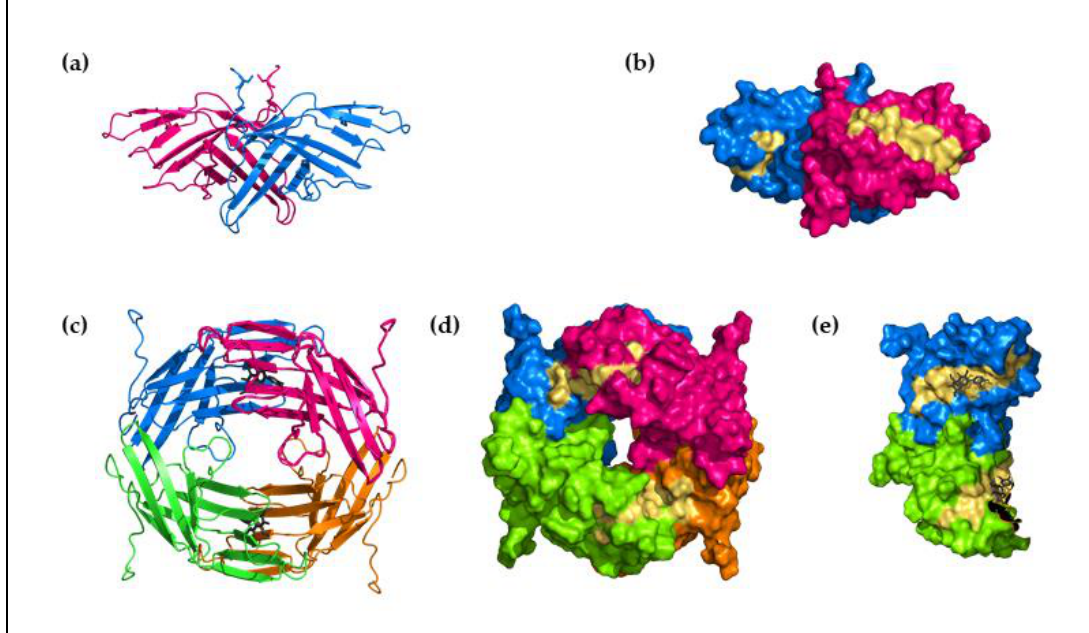
Figure 1. Protein structure of Alt a 1 : ( a ) Schematic diagram of the dimeric structure of Alt a 1 in its “butterfly” shape; ( b ) molecular surface of the dimeric structure of Alt a 1. Chains are shown in different colors and the position of the epitopes are shown in yellow, the epitopes are oriented to the outside of the structure leading the interaction with IgE antibodies; ( c ) schematic diagram of the tetrameric structure of Alt a 1; ( d ) molecular surface of the tetrameric structure of Alt a 1, chains are shown in different colors and the epitopes in yellow; ( e ) detail of the tetrameric molecular surface, showing the IgE binding epitopes (yellow) buried in the structure. PDB code,